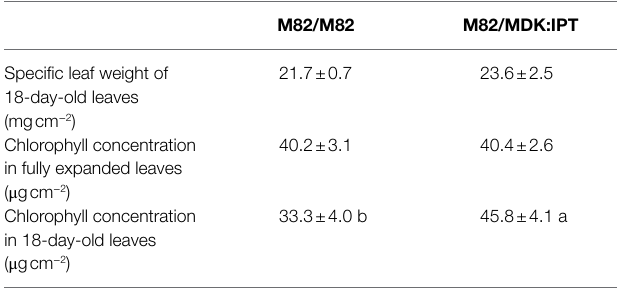
TABLE 3 | Specific leaf weight and chlorophyll concentration in old source leaves of M82 scions grafted on control M82 or transgenic MDK:IPT rootstocks. M82/M82